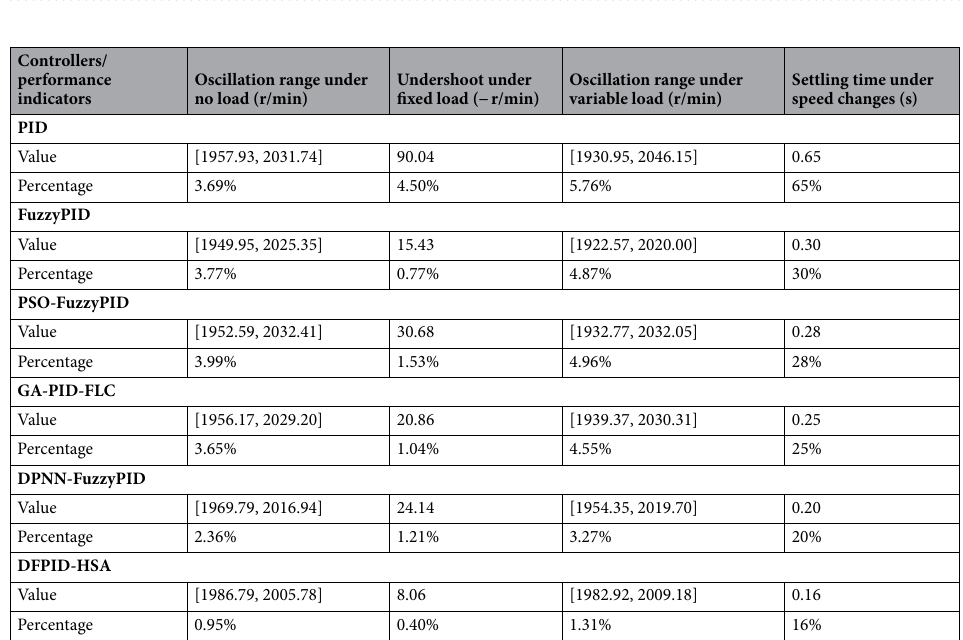
Figure 17. Experimental test results of DFPID-HSA: ( a ) No-load ( b ) Fixed Load ( c ) variable load ( d ) Speed changes.